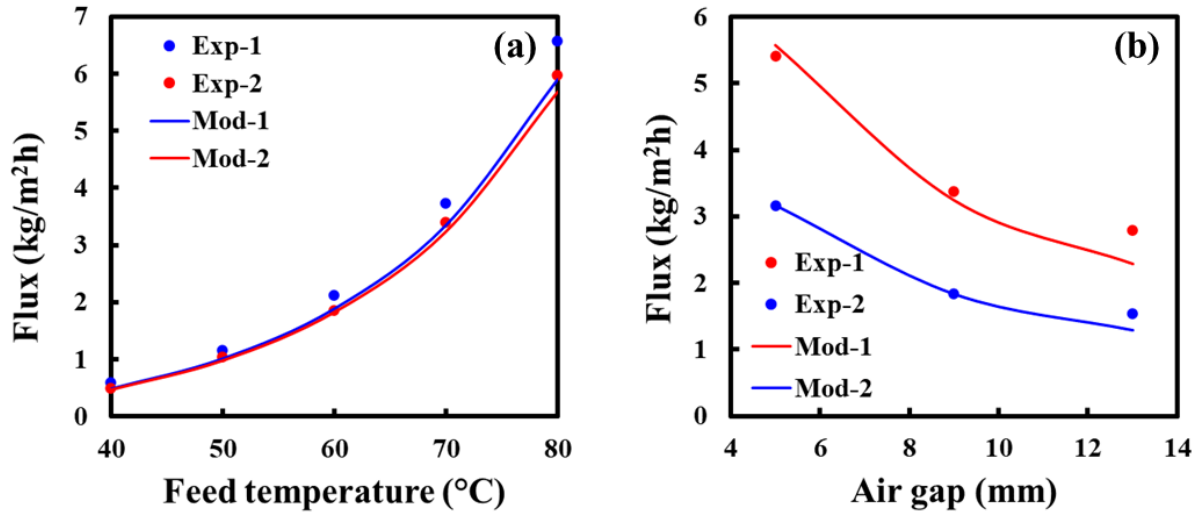
Figure A3. AGMD model validation (experimental data can be retrieved from [15]). ( a ) Impact of feed temperature and ( b ) air gap thickness on the membrane flux.